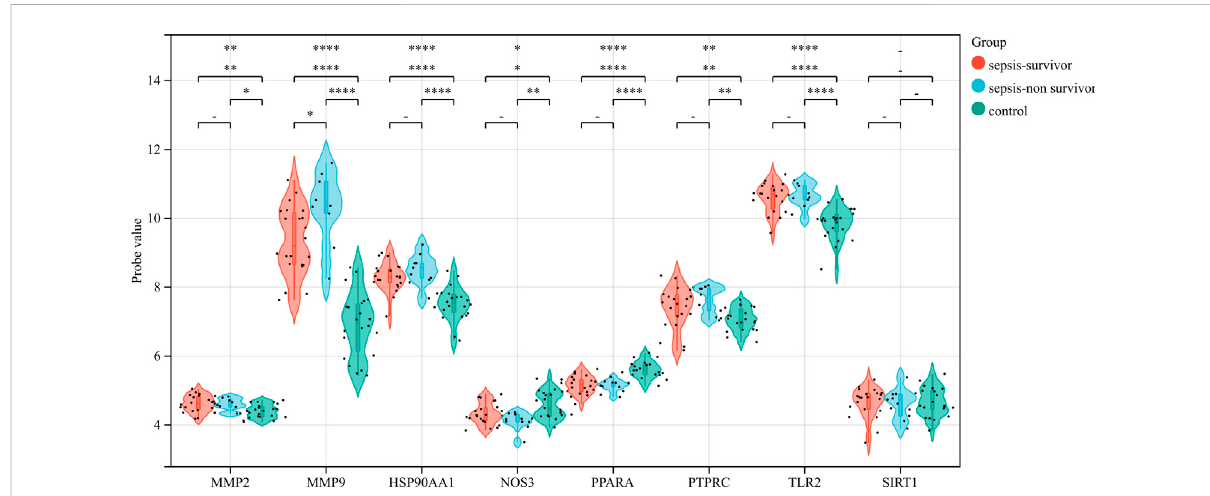
FIGURE 8 Eight hub genes were found in the sepsis survivor-control group (SS-C), sepsis non-survivor-control group (SN-C), and sepsis survivor-sepsis non-survivor group (SS- SN) differential expression analysis.